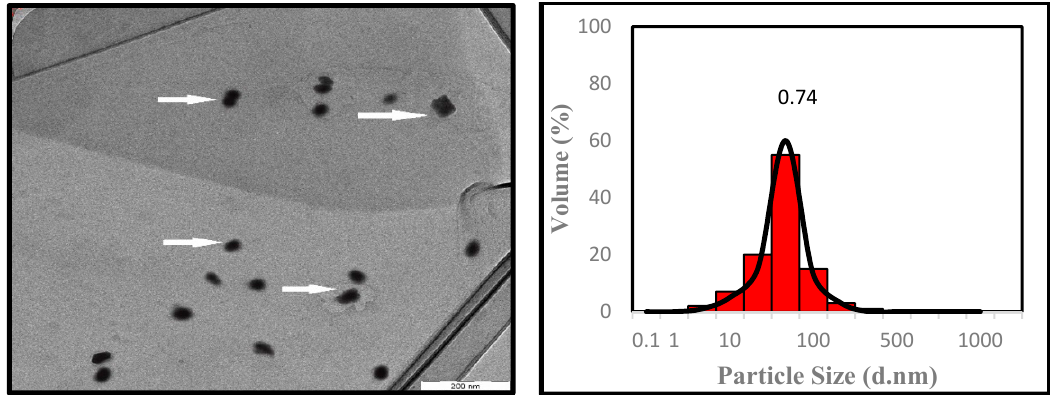
Figure 7. TEM micrograph (200 nm) and particle size distribution graph of palm oil ash nanoparticles.